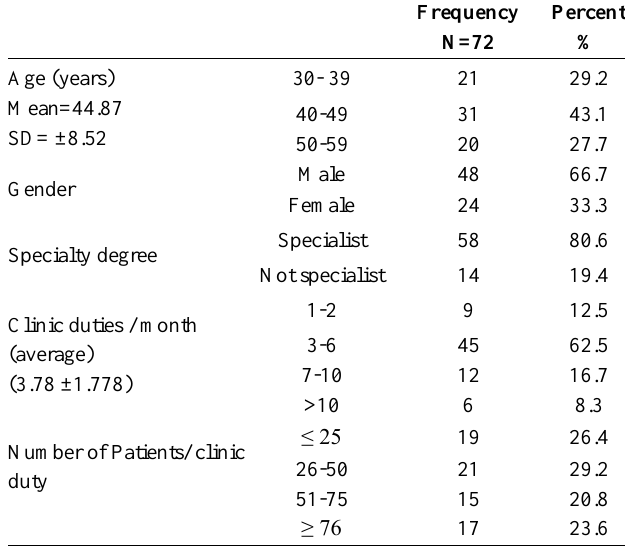
Table 1: Distribution of studied doctors according to their age, gender, specialty degree, and load of work